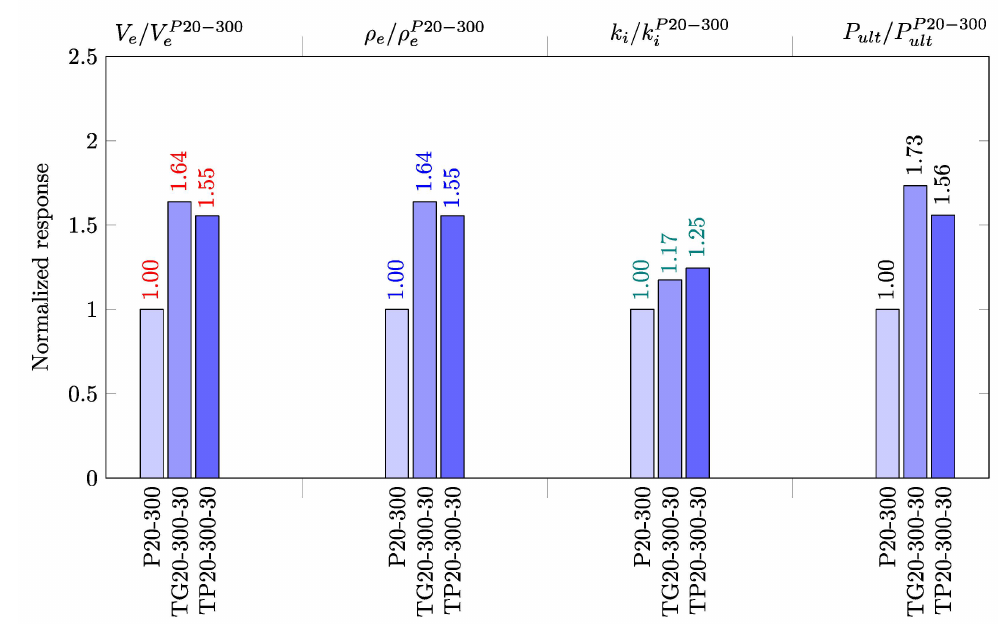
Figure 7. Effects of web corrugation type on the shear response of tested